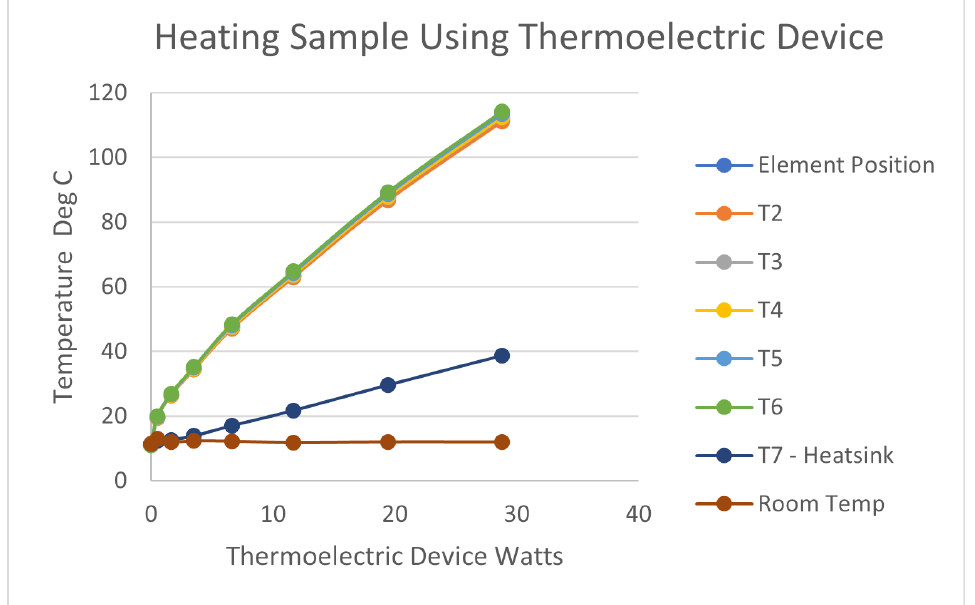
Figure 17. Graphed results of core sample thermal heating